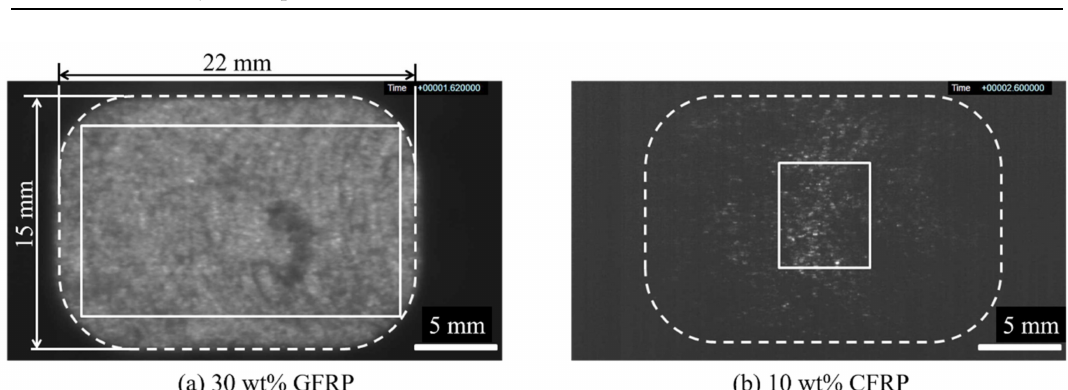
Figure 3. Observation image (Evaluation area: ( a ) 500 × 840 px (glass fiber reinforced polymer, GFRP); ( b ) 480 × 420 px (carbon fiber reinforced polymer,